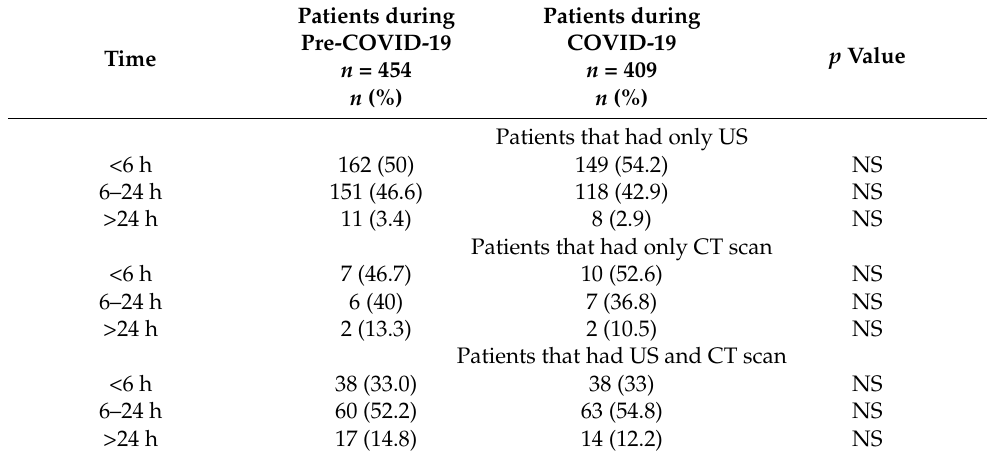
Table 3. Waiting time until surgery depending on radiological diagnostic modalities used.